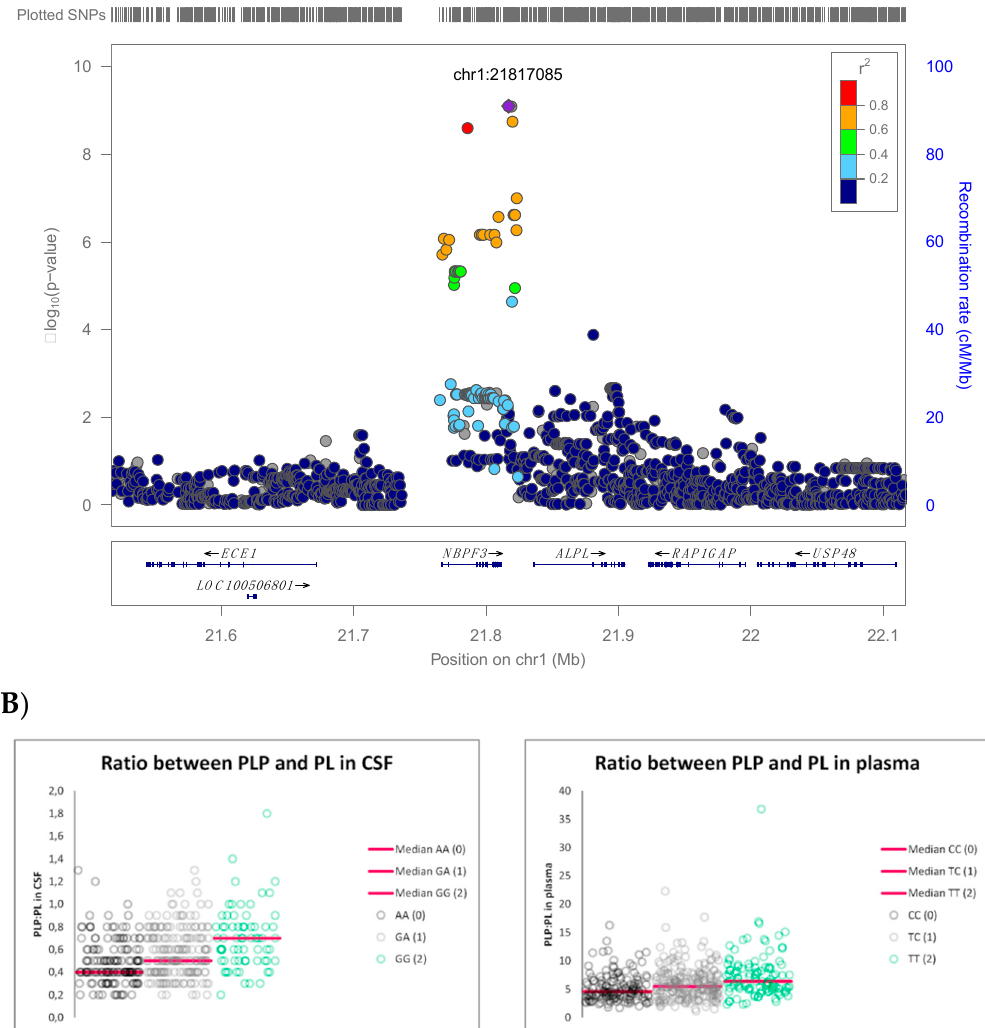
Figure 3. Regional association plot for the genome-wide significant locus for the ratio between PLP and PL on chromosome 1 ( A ) and scatterplots of the relation between genotype and measured PLP:PL in CSF (left) and plasma (right) ( B ).